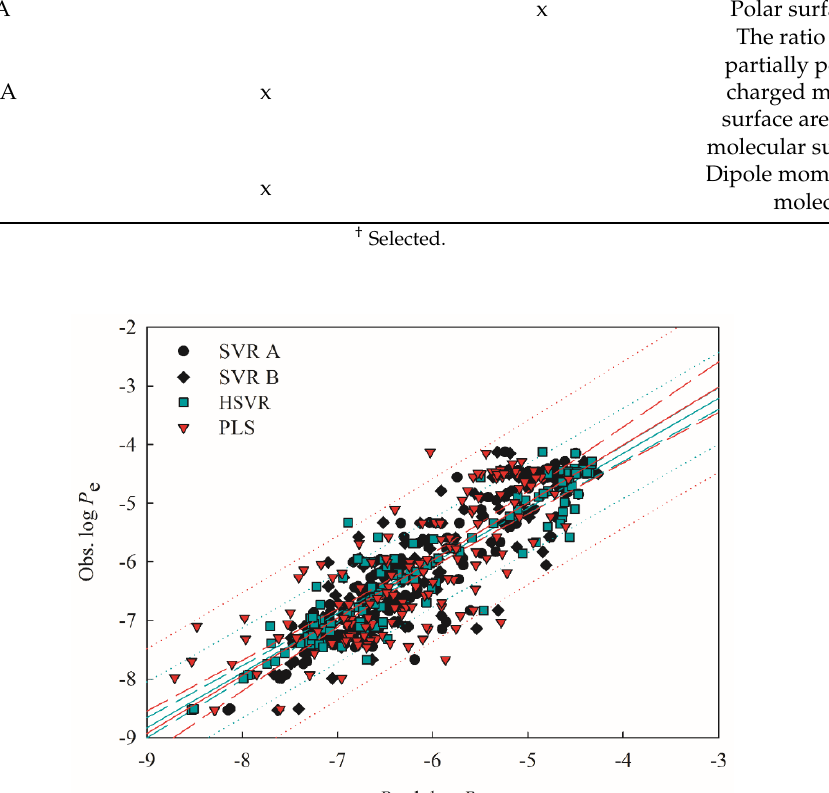
Table 1. Descriptor selected as the input of support vector regression (SVR) models in the ensemble and their descriptions.